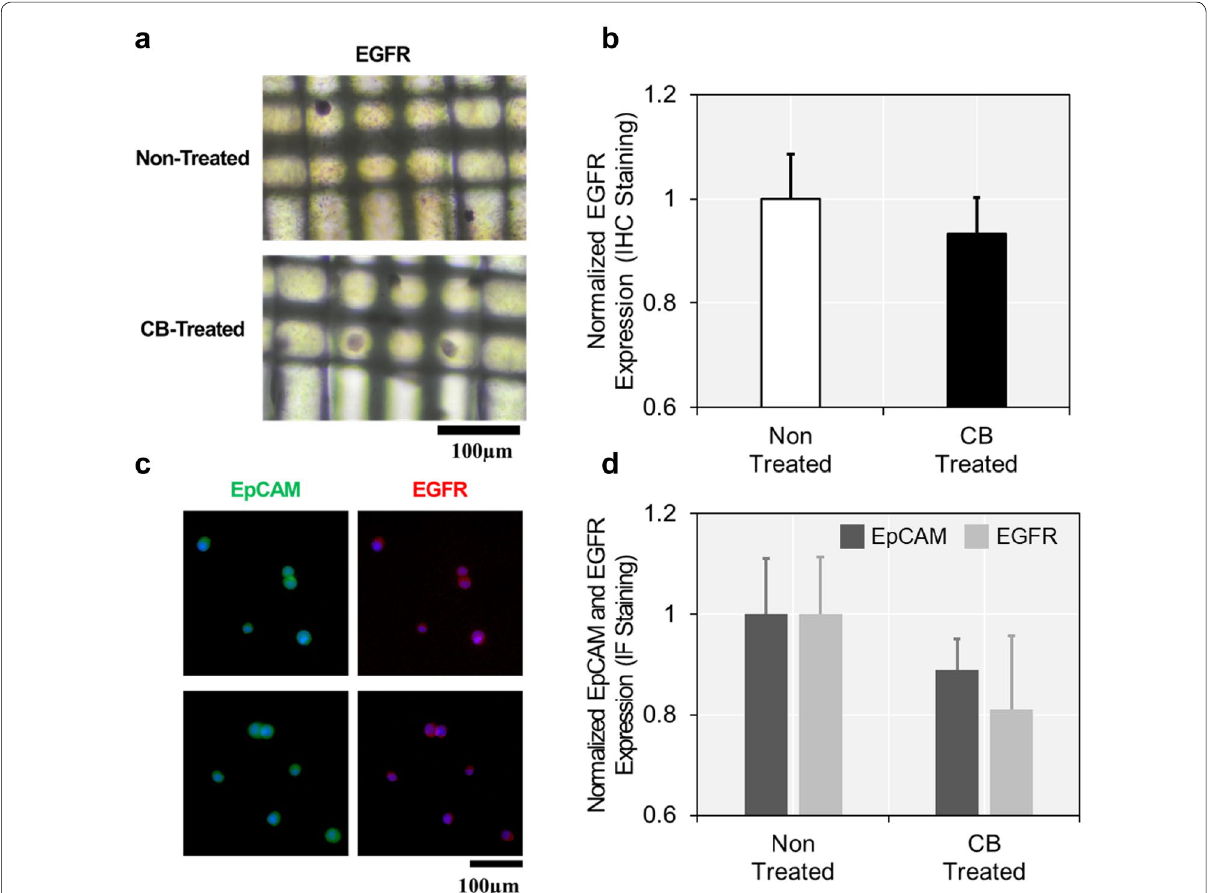
Fig. 3 Expression of tumor‑associated surface proteins on the cancer cells after CB treatment: a , b IHC staining was conducted directly on the cells captured on a fabric filter; c , d IF staining was conducted after releasing the cells from the filter. No significant differences were found in expression levels of EpCAM and EGFR, between CB‑treated and non‑treated